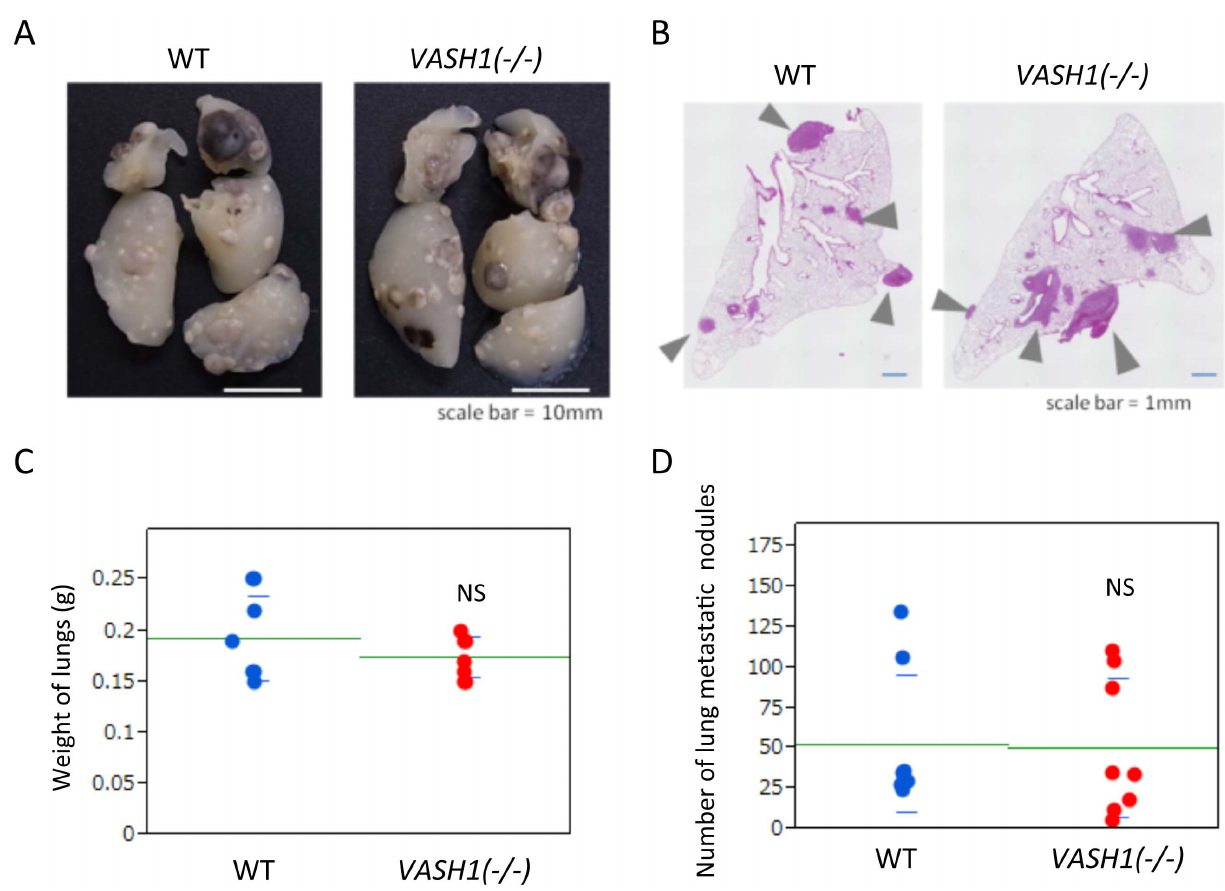
Figure 4. Lung metastasis in the experimental metastasis model. Eight days after injection of LLC cells via a tail vein, mice were sacrificed; and lung metastasis was then evaluated. A: Gross appearance. B: H&E staining. Arrowheads indicate metastasis. Bar=1 mm. C: Weight of lungs from WT and VASH1 ( 2 / 2 ) mice is given (N=8). NS: not significant. D: Number of metastatic nodules in the lungs from WT and VASH1 ( 2 / 2 ) mice is shown (N=8). NS: not